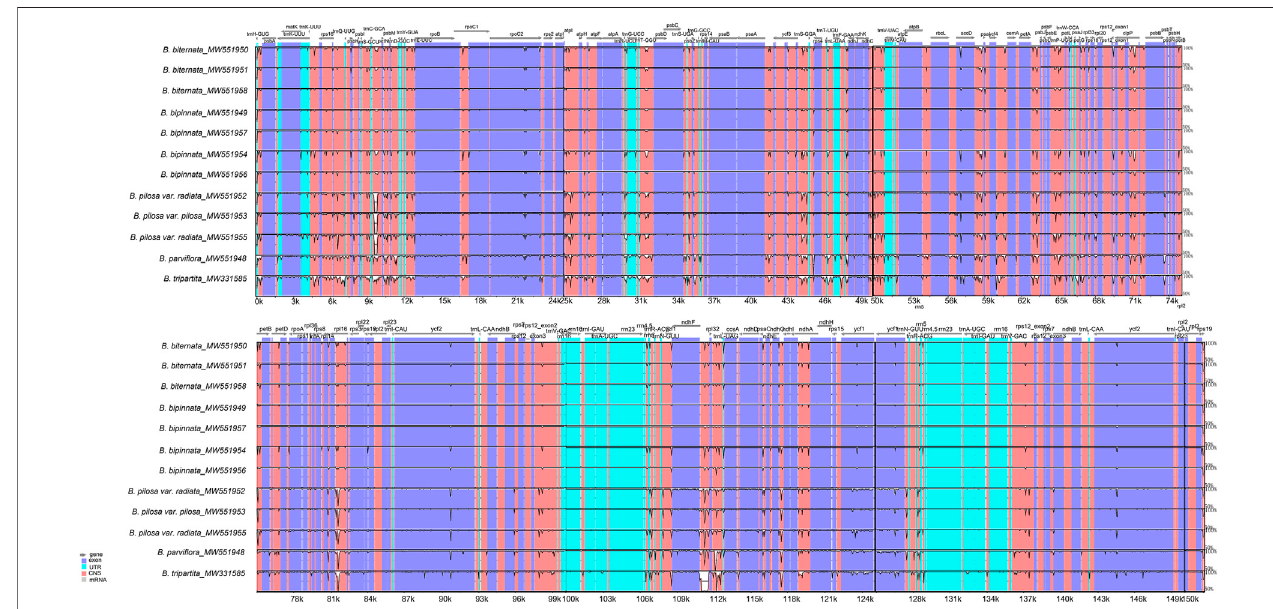
FIGURE4| Global alignmentofthechloroplast genomesof Bidens species.The x -axis represents the coordinates inthechloroplast genome.The y -axis indicates the average percent identity of sequence similarity, which ranged between 50 and 100%, in the aligned regions.